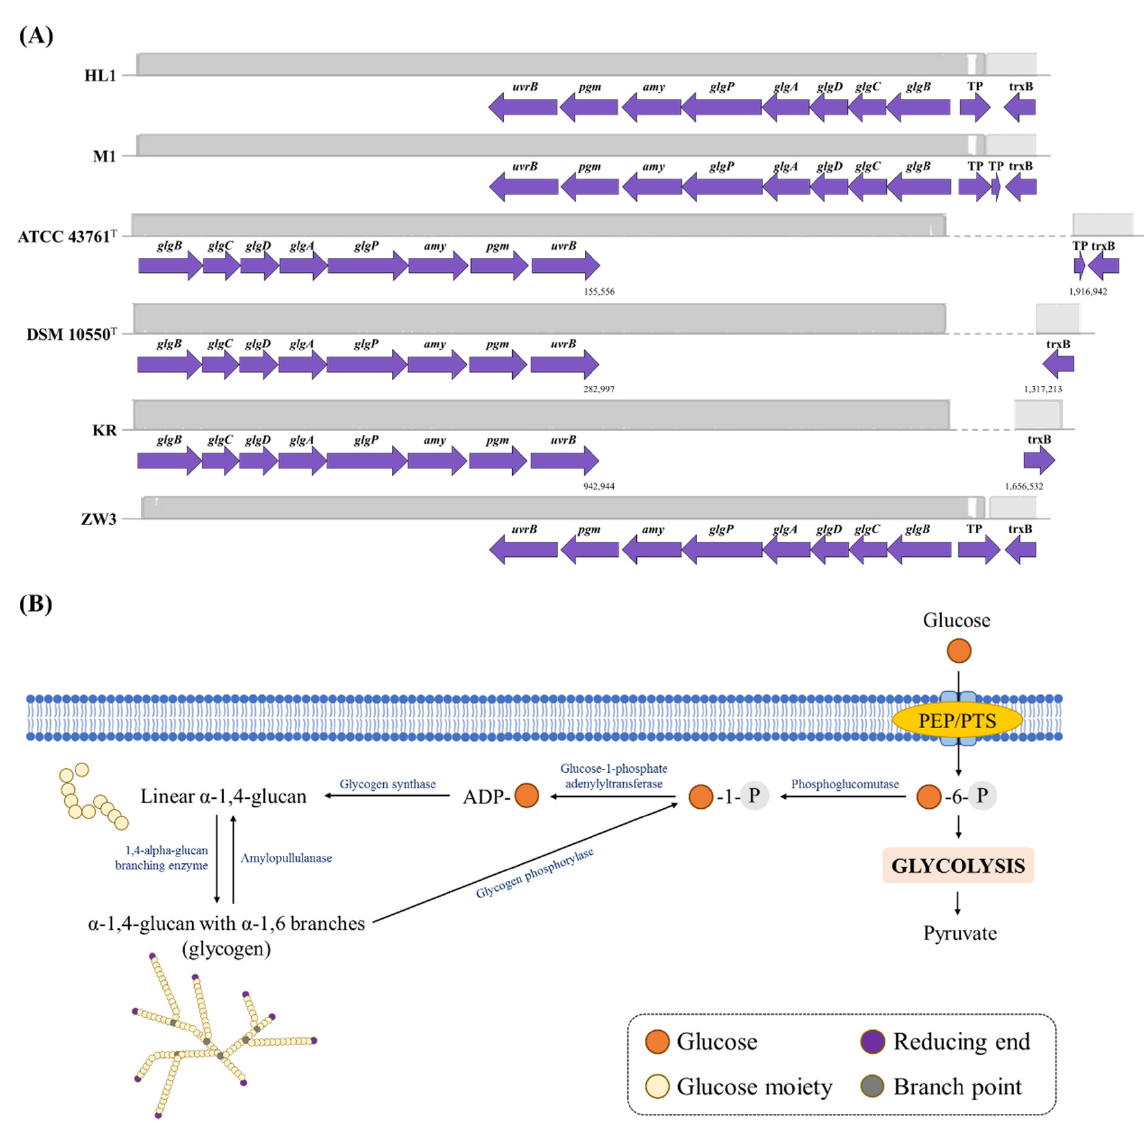
Figure 5. ( A ) Genetic organization of the glycogen metabolism gene clusters in L. kefiranofaciens strains. Gene functional groups are marked with different colors. ( B ) The proposed biosynthesis pathway in L. kefiranofaciens strains for glycogen production, according to the KEGG